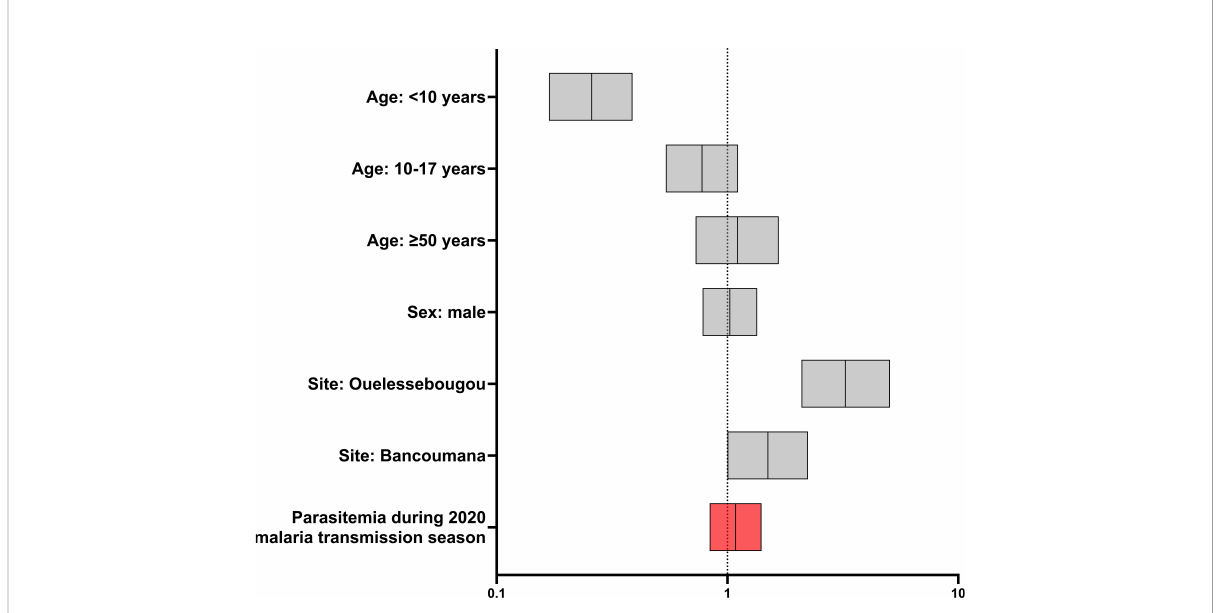
FIGURE 2 Effect of parasitemia and selected demographic covariates on new COVID-19 seroconversion during 2020 malaria transmission season (n=1314). Forest plot of odds ratios and 95% con fi dence intervals following logistic regression. Age group 18-49 years and Doneguebougou site were used as reference groups for nominal